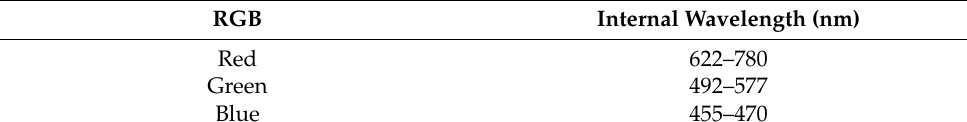
Table 2. Internal visible light wavelength.